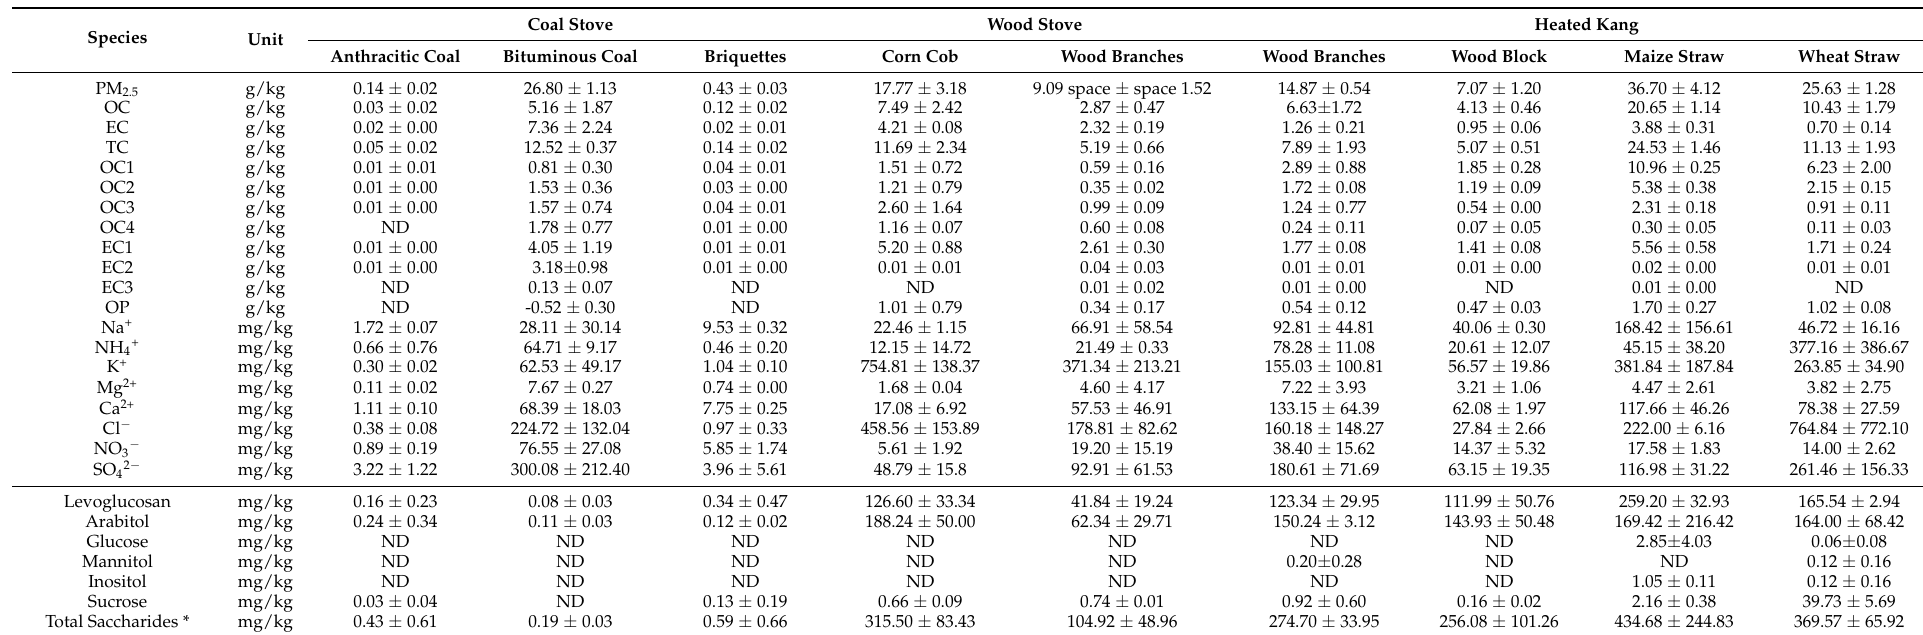
Table 2. Emission factors of various substances of fuel under different combustion